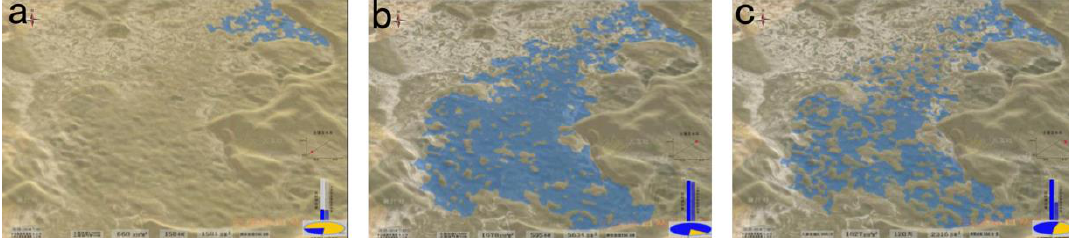
Figure 6. Effect of dynamic simulation for water supplementation. ( a ) initial stage; ( b ) drained stage; ( c ) evaporation completing stage.